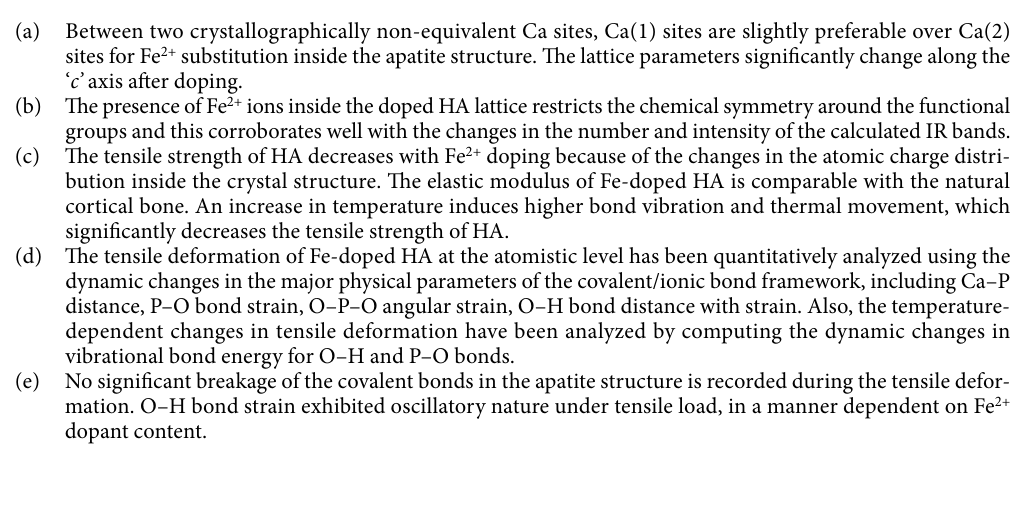
Figure 15. Oscillatory behaviour of O–H bond strain under tensile loading, as analyzed using MD simulation, for different Fe-doped HA at T = 10 K. OH group is shown in the inset, with atomic colour code: O: red, H: white. (Sample designation: xFeHA means x mol% Fe 2+ -doped